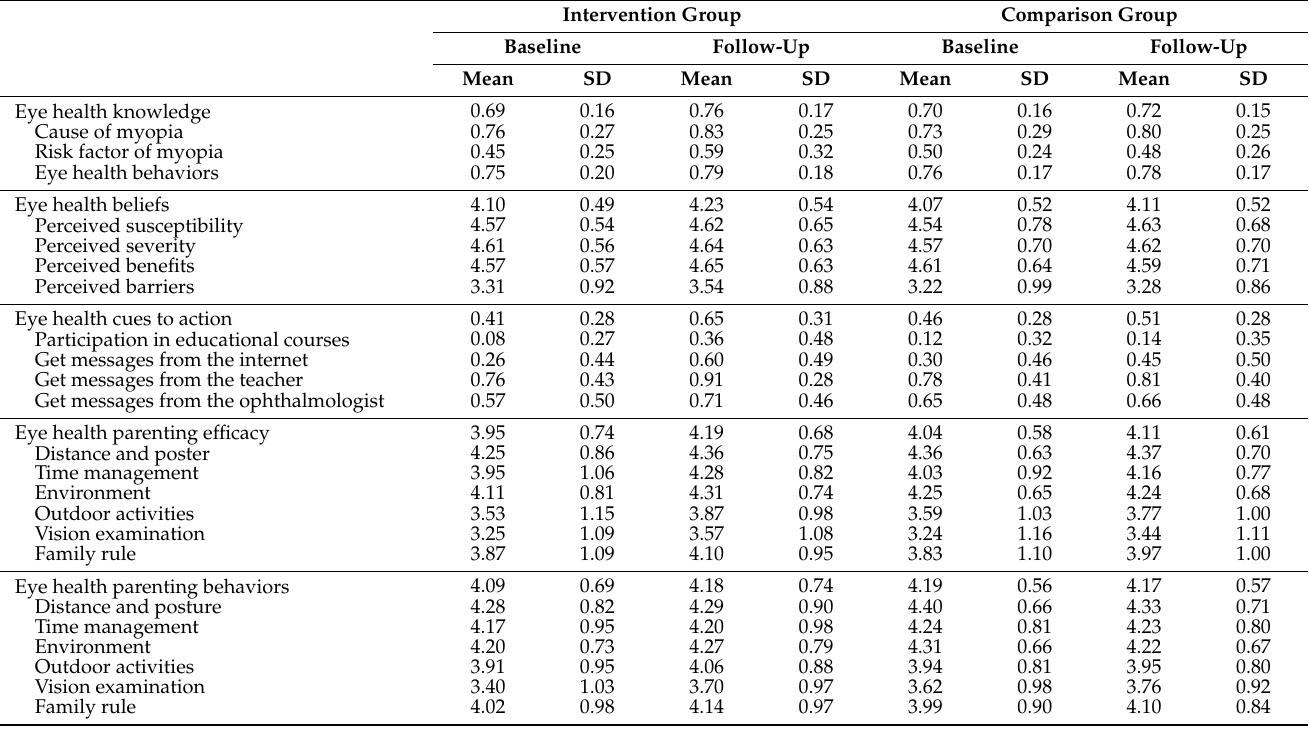
Table 3. Parents’ eye health knowledge, beliefs, cues to action, parenting efficacy, and parenting behaviors for the intervention and comparison groups based on the baseline and follow-up surveys. Intervention Group Comparison Group Baseline Follow-Up